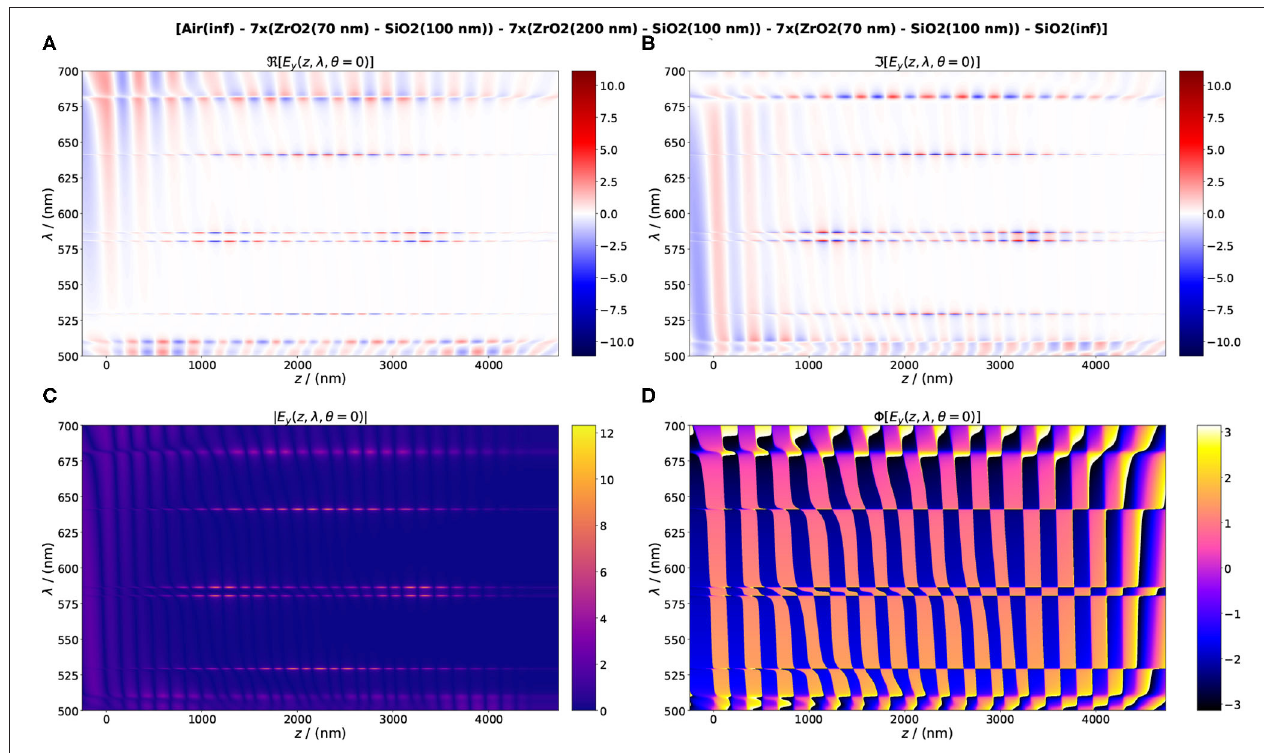
FIGURE 12 | Optical Tamm states in a symmetric structure constituted by 3 one-dimensional photonic crystals. The unit cell of the first and the third PCs is made of layers with quarter wavelength thickness. The unit cell is built by a central layer of lower refractive index n l and thickness of λ/ (4 n l ), surrounded by two layers of thickness λ/ (8 n h ) of a material with higher refractive index. The wavelength λ is selected to be central wavelength of the first bandgap. In the central PC, the thickness of the layers of low refractive index can remain the same, whereas the thickness of the layer of high refractive index is increased in order to achieve a band inversion. In the bandgap the amplitude of the fields decays rapidly, except at the wavelengths corresponding to edge states. (A) real part, (B) imaginary part, (C) modulus and (D) phase of the electric field across the photonic crystal structure. The optical Tamm states are in the middle of the band